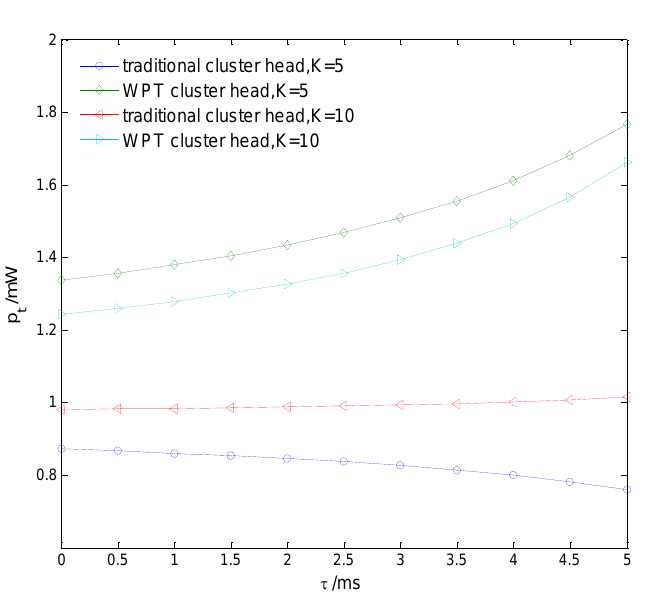
Figure 11. BER of reporting information.